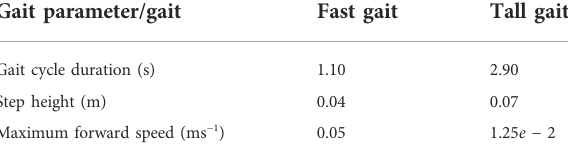
Algorithm 6. Terrain type clustering, goal identi fi cation, and